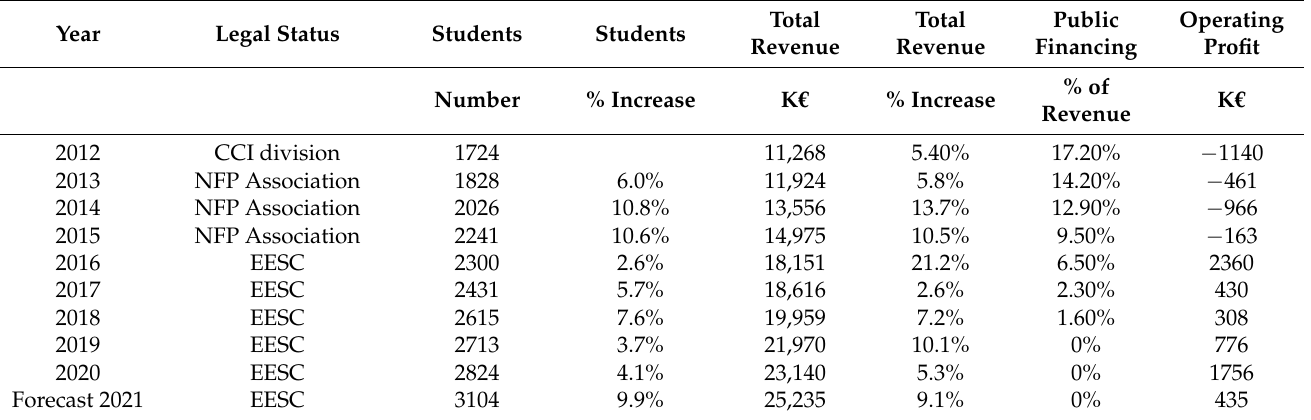
Table 3. Financial and Operating results of BSB before the transformation, as a not-for-profit (NFP) and as a social business